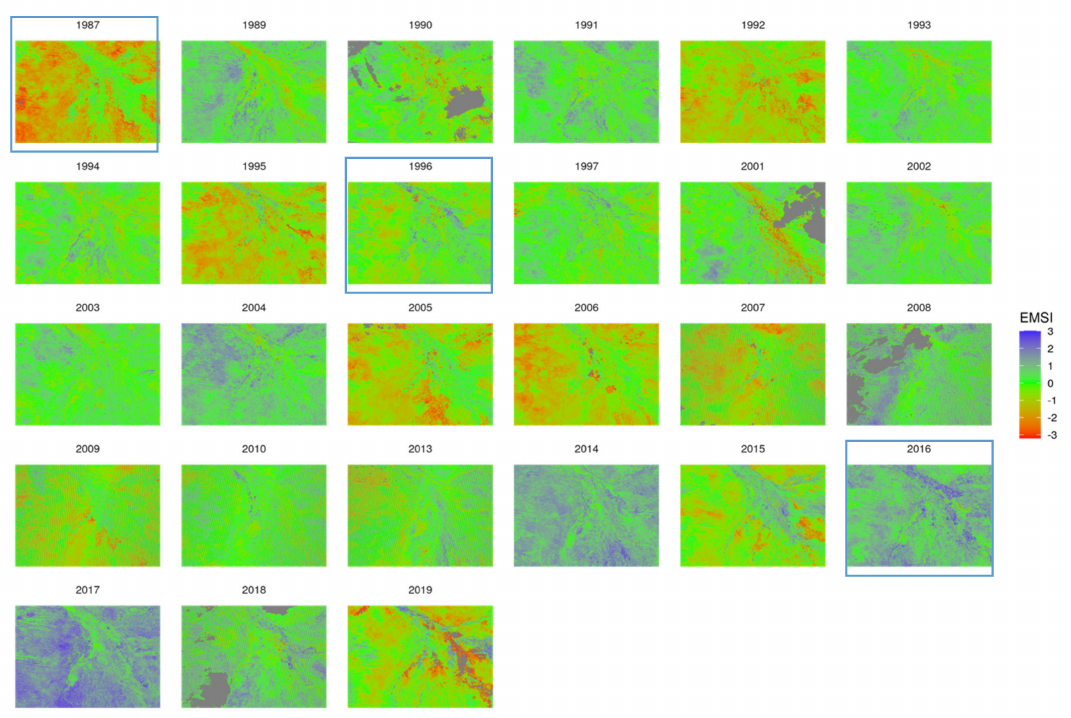
Figure A4. EMSI for 1987–2018 Landsat 5, 7, and 8 time series for the month of March over the Okavango Delta. The years 1988, 1998–2000, 2011, and 2012 had no clear sky scenes. Note, the behavior of the uplands and the delta are not synchronized across years. The years 1987, 2002, and 2003 are average years in the delta but highly stressed in the uplands. The years 1989 and 2008 were below average for the delta (which is typically green in the NDVI), but above average for the surrounding uplands. The three highlighted boxes are shown below in more detail in Figure 8. Pixels with no data due to masking are